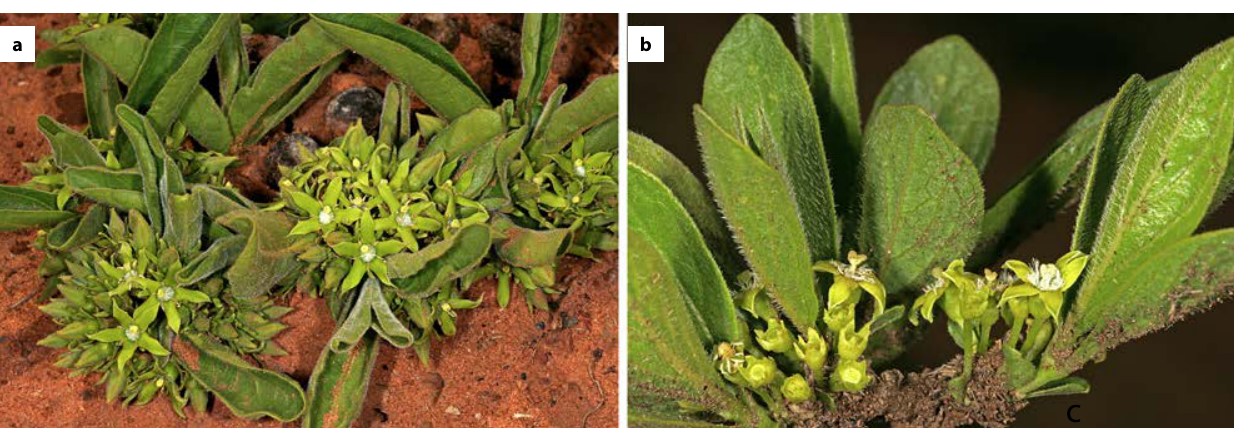
Figure 2: (a) Vangueria pygmaea (= Pachystigma pygmaeum ) and (b) Bridsonia chamaedendrum (= Pygmaeothamnus chamaedendrum ) Photographs: A.E. van